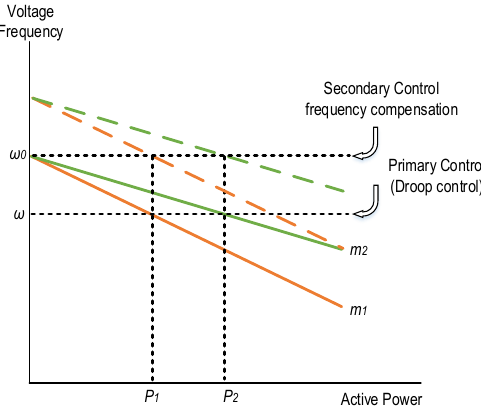
Figure 5. Illustration of active power sharing between two parallel inverters using conventional droop method. The secondary response of the hierarchical control is also